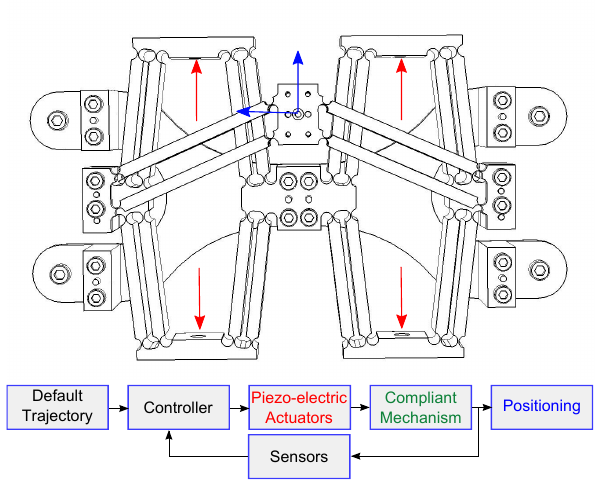
Figure 1. Prototype of a compliant mechanism used in a feed unit for novel machine tools as component of the mechatronic system.